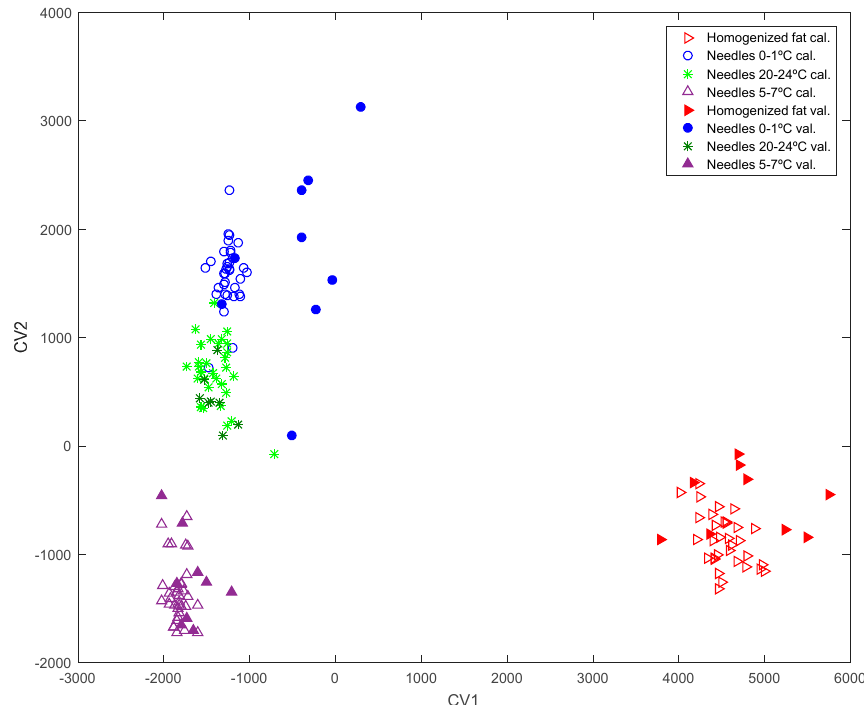
Figure 3. PCA-LDA model obtained from different groups of samples analyzed by GC-IMS: Samples taken with needles at a temperature of 0–1 °C, Samples taken with needles at a temperature of 5–7 °C, Samples taken with needles at a temperature of 20–24 °C, homogenized fat. The same filled markers show validation samples.